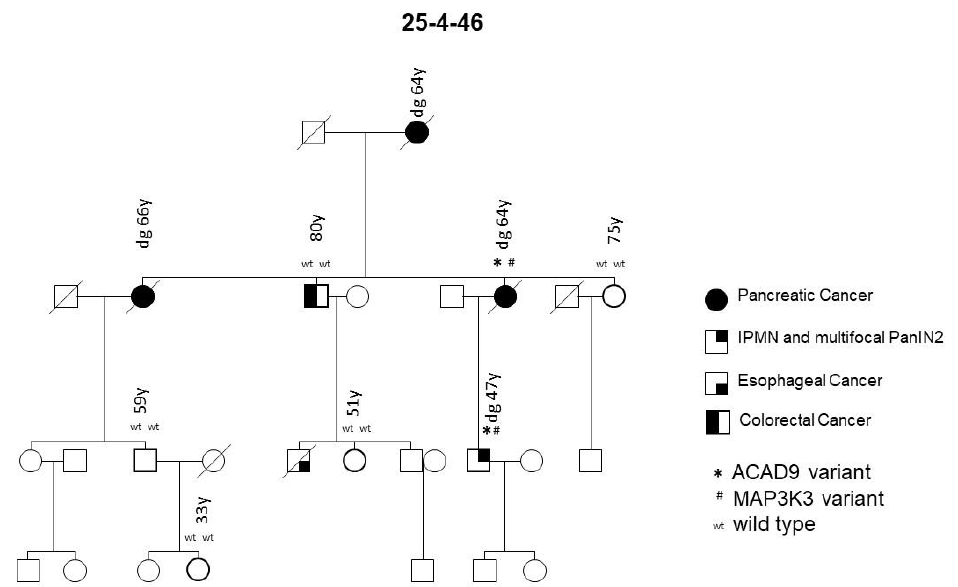
Figure 4. FPC family with MAP3K3 and ACAD9 germline variants. Diagonal lines indicate de- ceased individuals.